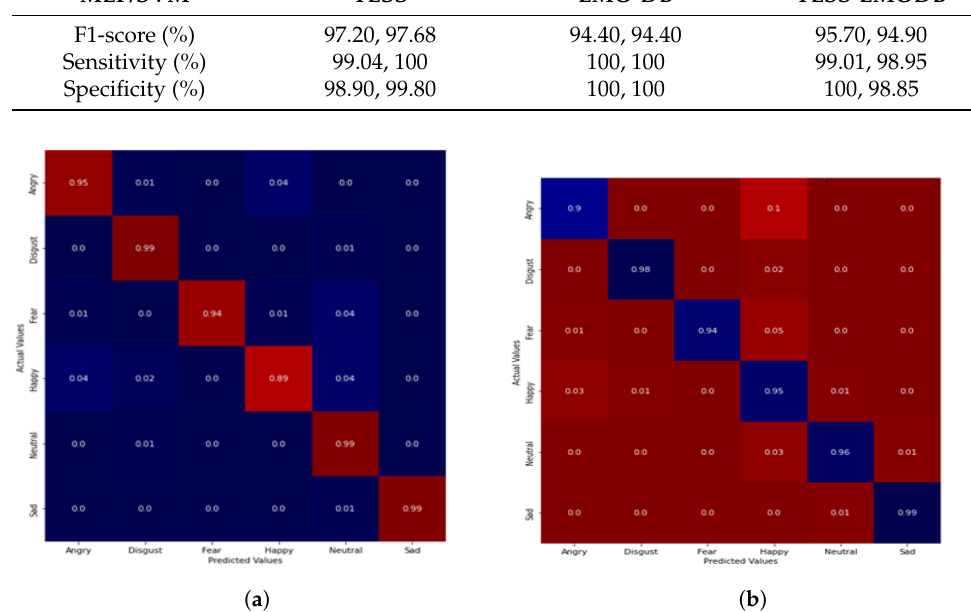
Figure 6. Confusion matrix of emotion classification on TESS-EMODB dataset. ( a ) DCNN-NCA-MLP. ( b )